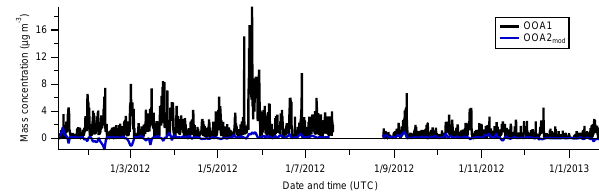
Figure 4. Time series of OOA1 and OOA2 mod , where OOA2 mod is the daily average.